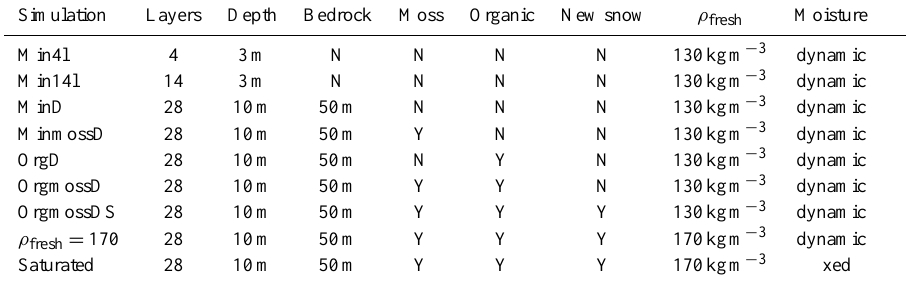
Table 1. List of JULES simulations carried out. ρ fresh is the density of fresh snow. Simulation Layers Depth Bedrock Moss Organic New snow ρ fresh Moisture Min4l 4 3m MinD